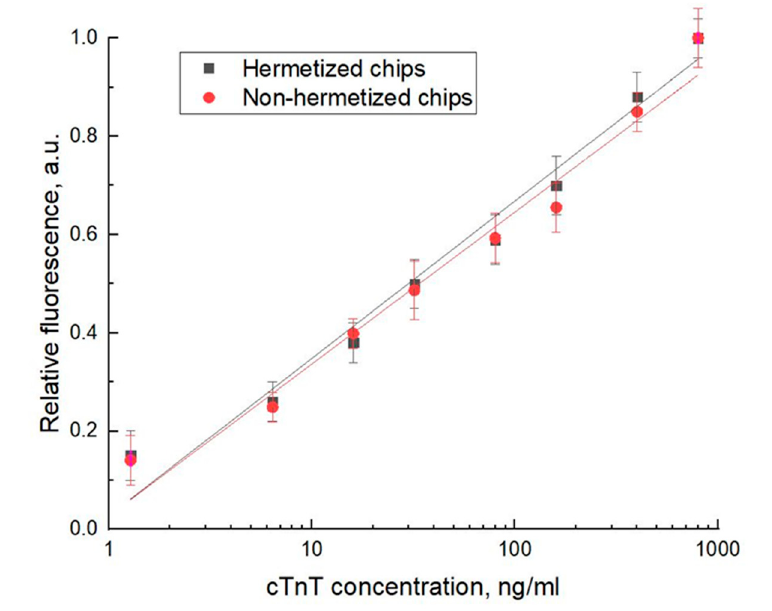
Figure 13. The relationship of relative fluorescence versus concentration of cTnT solutions as measured using microfluidic biochips fabricated according to the described technology for hermetized chips (black line) and non-hermetized chips (red line).